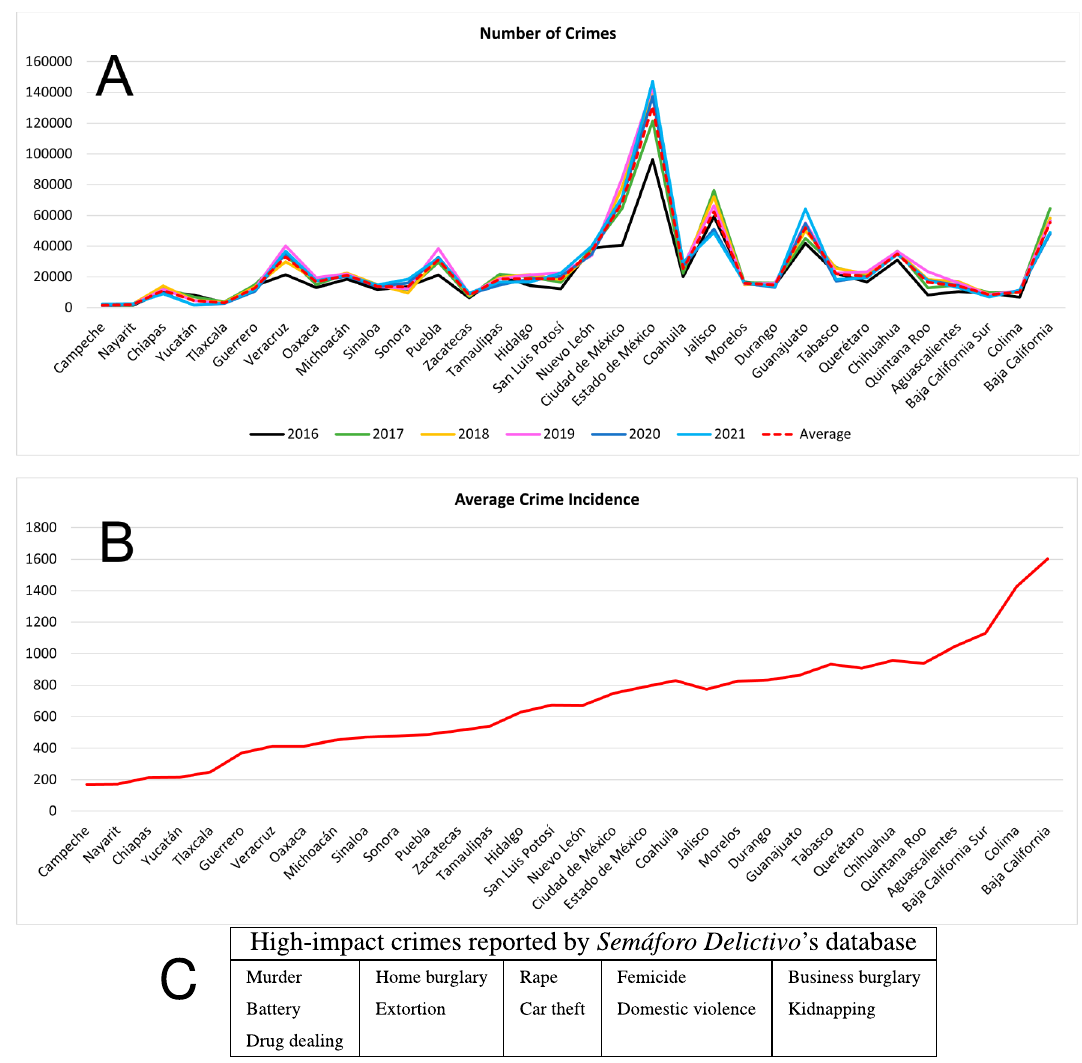
Figure 1. Crime levels in Mexico. ( A ) Number of crimes in each of the 32 Mexican States from 2016 to 2021. The red dotted line is the average over these six years. ( B ) Average crime incidence (number of victims per 100,000 inhabitants per year) for each Mexican State, shown in increasing tendency. The average is taken from 2016 to 2021. ( C ) High-impact crimes reported in the Semáforo Delictivo data base 26 and used to construct the graphs in ( A ) and ( B